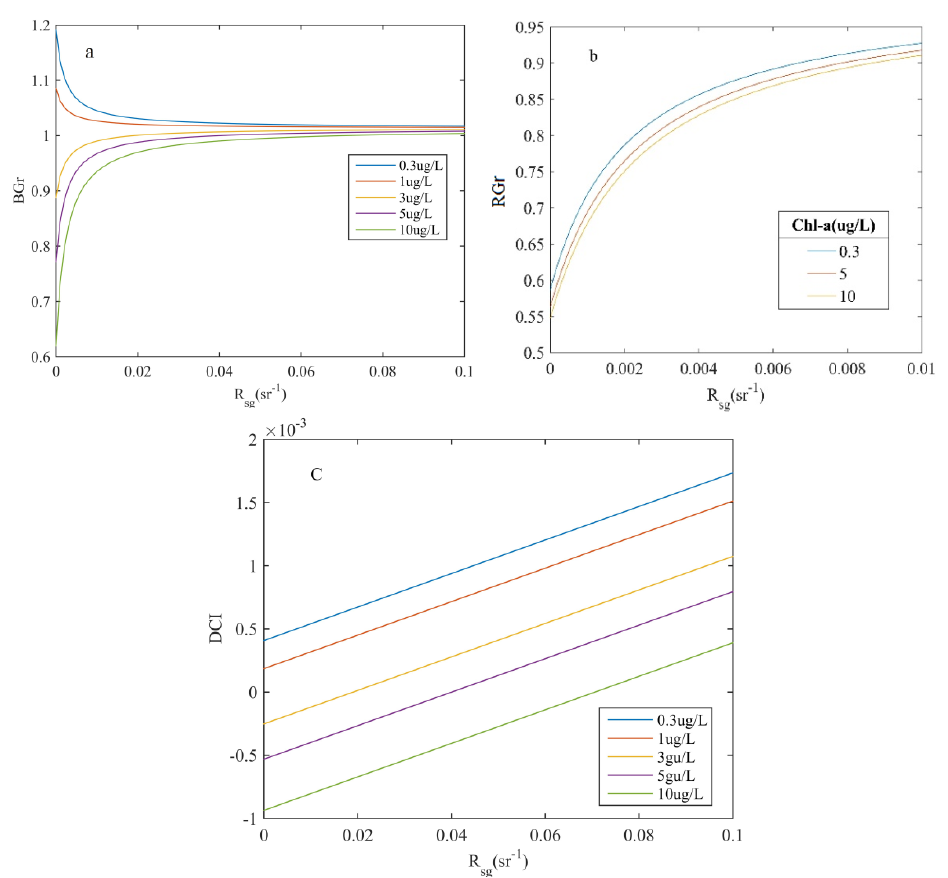
Figure 15. Remote sensing reflectance contributed by sun glint ( R sg ) against the following: ( a ) the ratio of R ap (490) to R ap (560); ( b ) the ratio of R ap (560) to R ap (660); and ( c ) the difference between R ap (490) and R ap (560).